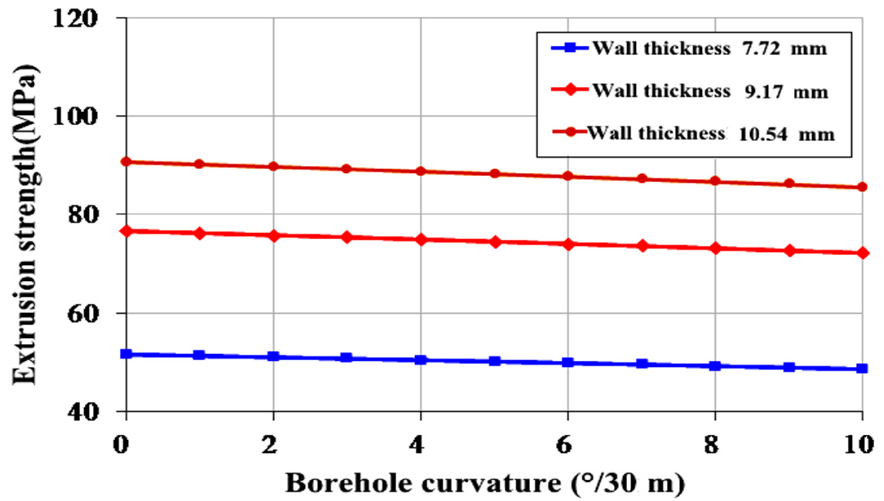
Figure 9. Casing extrusion strength under different borehole curvature.